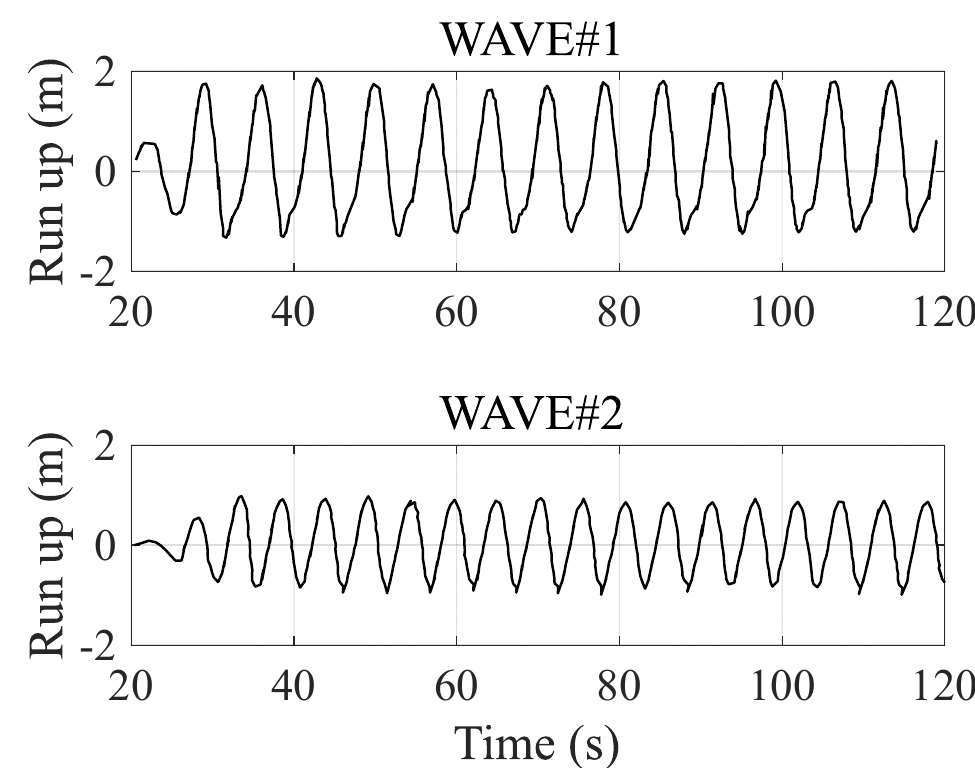
Figure 8. Wave run-up time series of regular Wave#1 and Wave#2 .